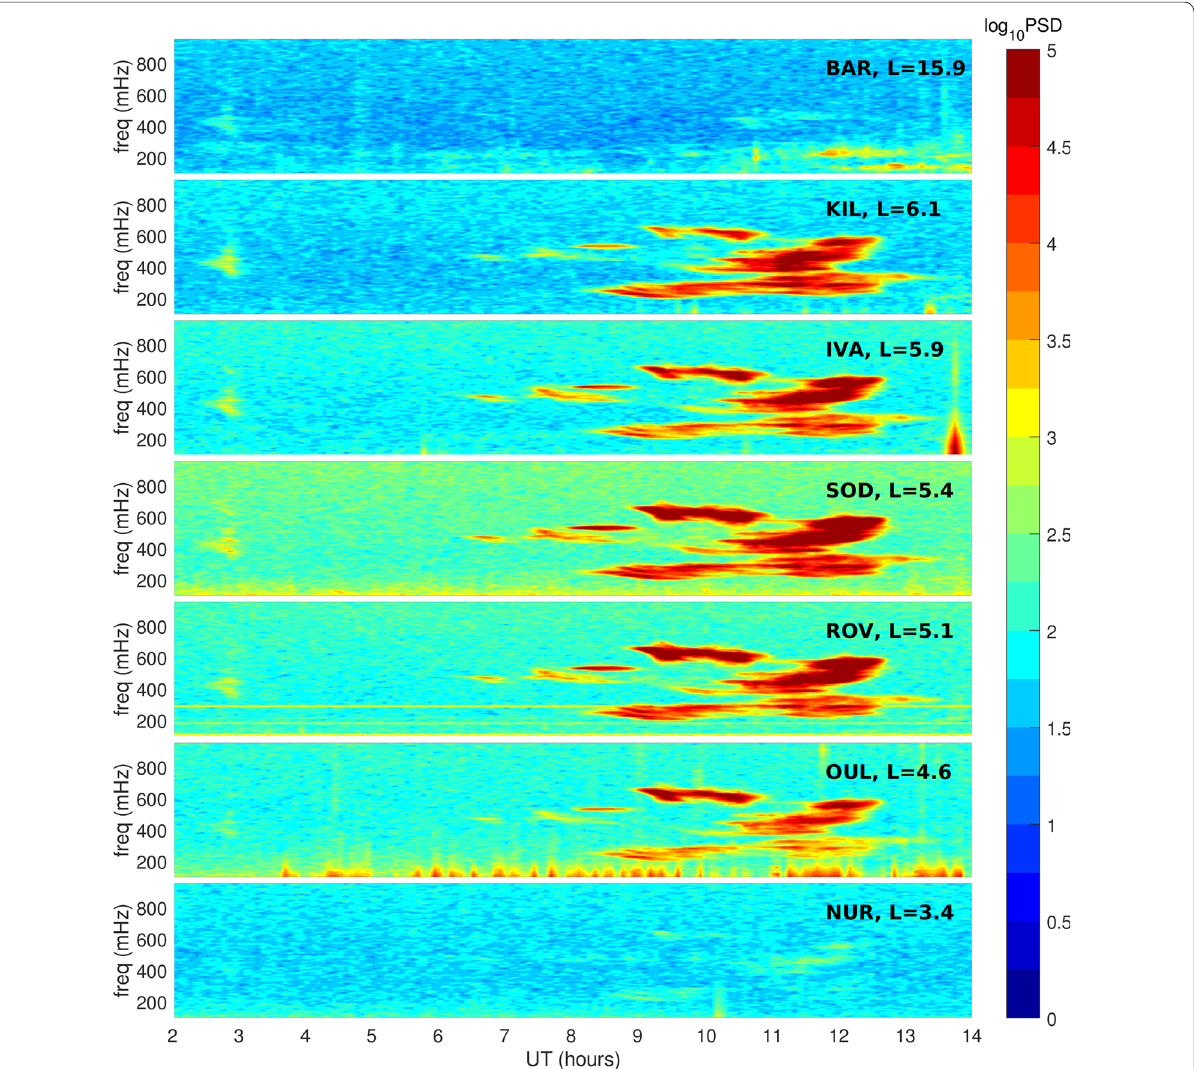
Fig. 6 The dynamical spectra of Pc1 pulsations along the Finnish pulsation magnetometer chain on 22 February 2007 between 0200 and 1400